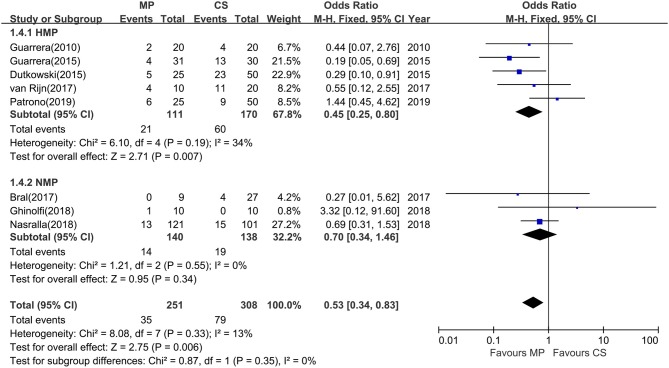
Meta-analysis on total biliary complications rates between MP and CS preservation. HMP reduced the total biliary complications (OR = 0.45; 95% CI = 0.25–0.80; P = 0.007), but NMP cannot reduce the total biliary complications (OR = 0.70; 95% CI = 0.34–1.46; P = 0.34). MP, machine perfusion; CS, cold storage; HMP, hypothermic machine perfusion; NMP, normothermic machine perfusion; CI, confidence interval.